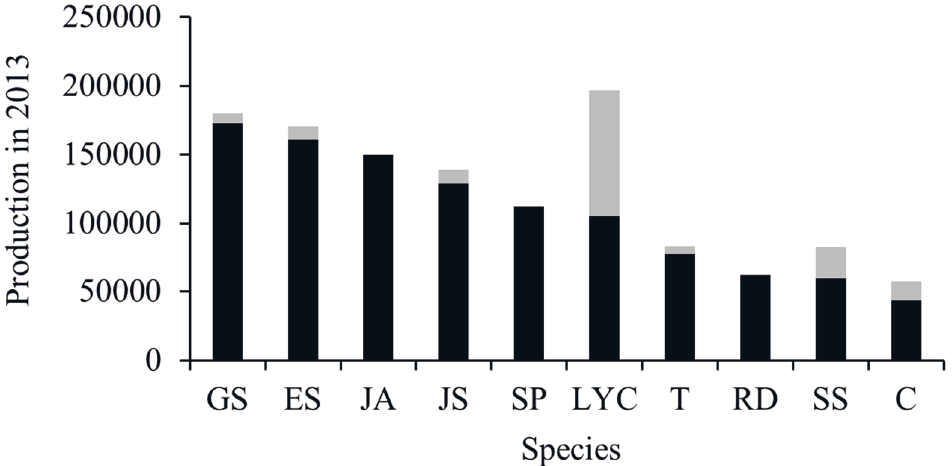
Figure 7. Global production of the top ten farmed marine species, aquaculture ( black ) and fisheries ( grey ). Gilthead seabream (GS); European seabass (ES); Japanese amberjack (JA); Japanese seabass (JS); subnose pompano (SP); large yellow croaker (LYC); turbot (T); red drum (RD); silver seabream (SS) and cobia (C). The fisheries production of JA, SP and RD are 0, 79, and 204 tons respectively (see Appendix for scientific